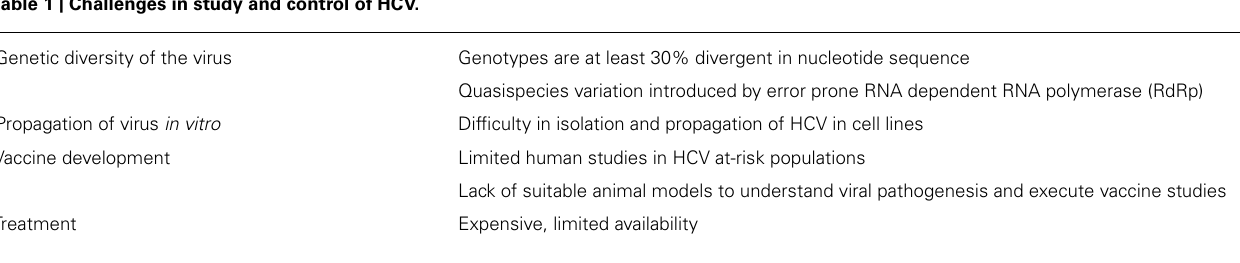
Table 1 | Challenges in study and control of HCV. Genetic diversity of the